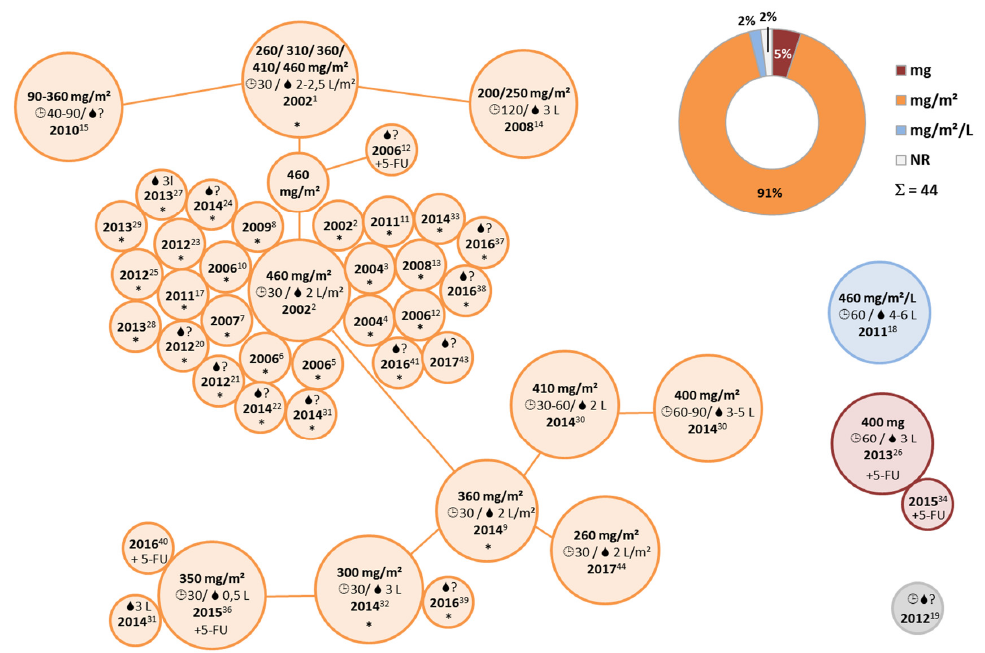
Figure 6. Overview of HIPEC protocols using L-OHP: Depiction of different drug dosages and measures thereof (pie chart with percentages) among protocols using L-OHP ( n = 44). Connections and circle sizes are arbitrary and protocols were compiled manually, according to respective similarities. Related publications are annotated by superscript numbers, conforming to annotations in Table S4. Abbreviations and symbols: 5-FU (5-fluorouracil i.v.); (amount of diluent); (duration of HIPEC); * (bidirectional protocol with 5-FU/Leucovorin); and L-OHP (oxaliplatin).